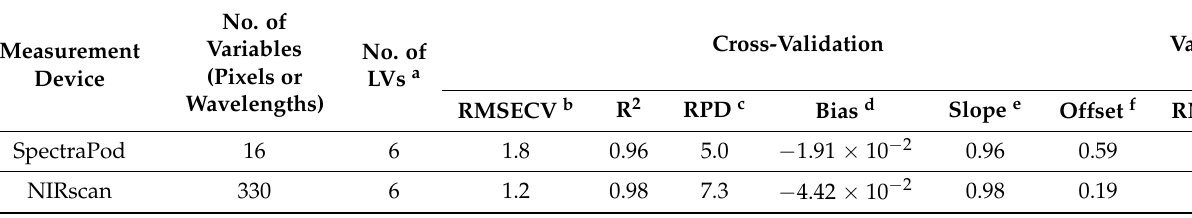
Table A1. Composition of the calibration and test sets for the plastic classification experiment. Table A2. Model statistics for the prediction of moisture content.